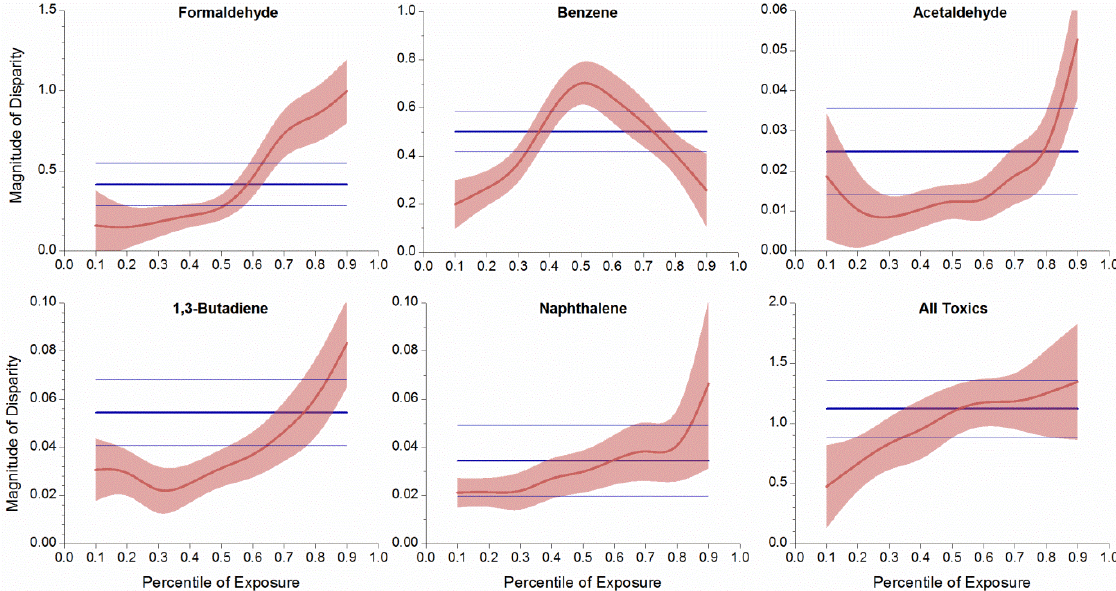
Figure 6. Uneven magnitude of racial disparity over exposure